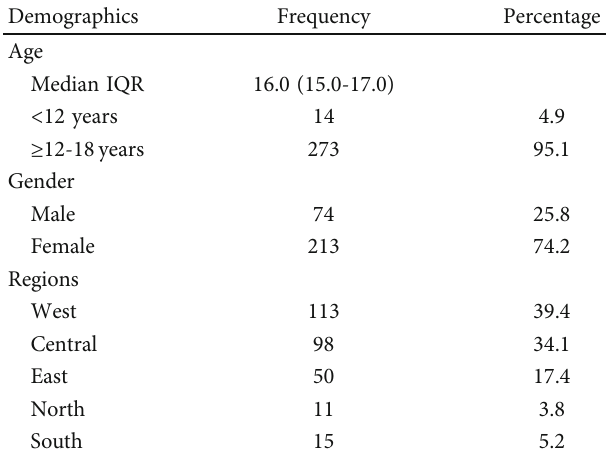
Table 4: Signs and symptoms and the involvement of CNS region among individuals with pediatric onset MS ( n = 287 ).